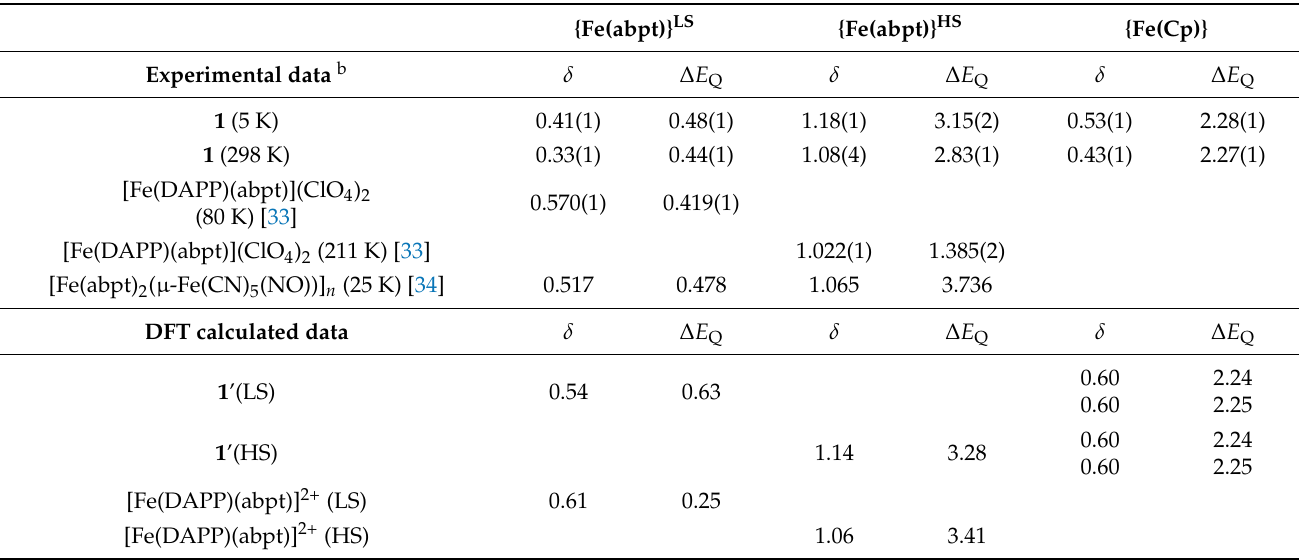
Table 2. Experimentally determined 57 Fe Mössbauer parameters for 1 and other Fe II complexes with abpt ligand a